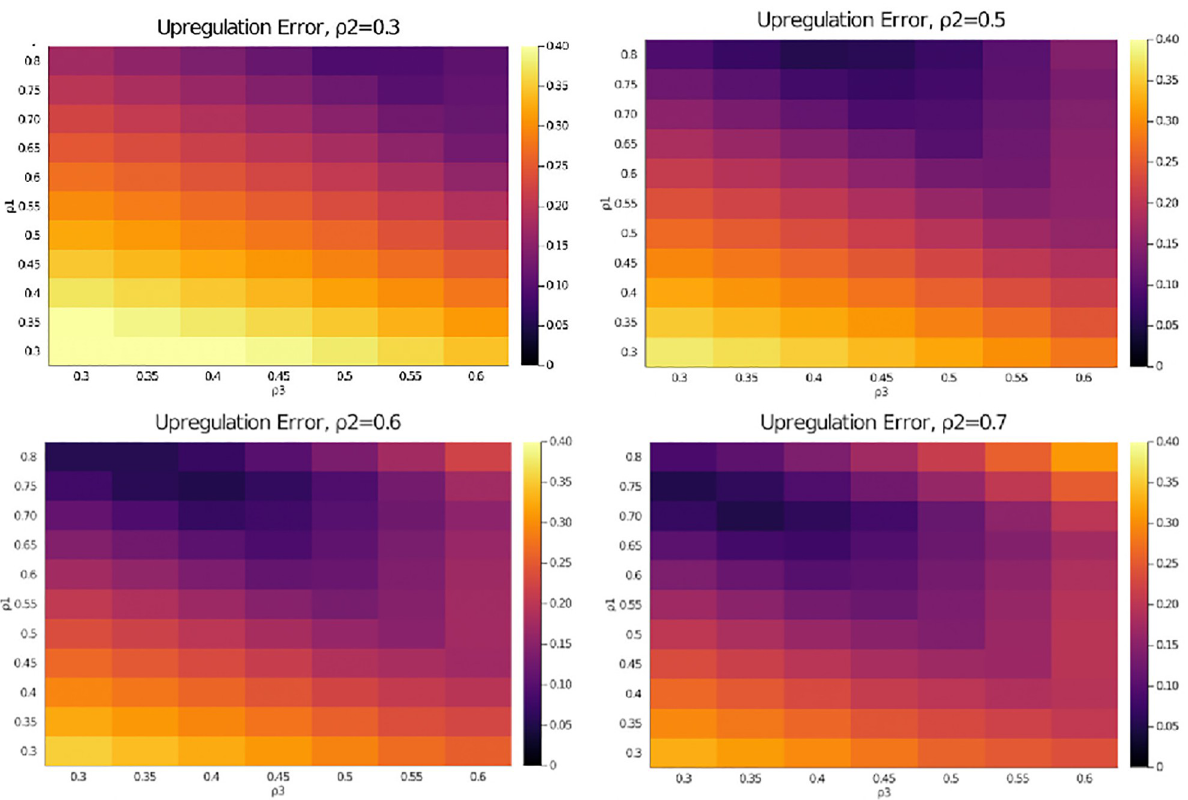
Fig 8. Heatmap plots of the predictive error (7) with respect to up-regulation of total and right vs left transport for different values of the directional parameters ρ 1 , ρ 2 and ρ 3